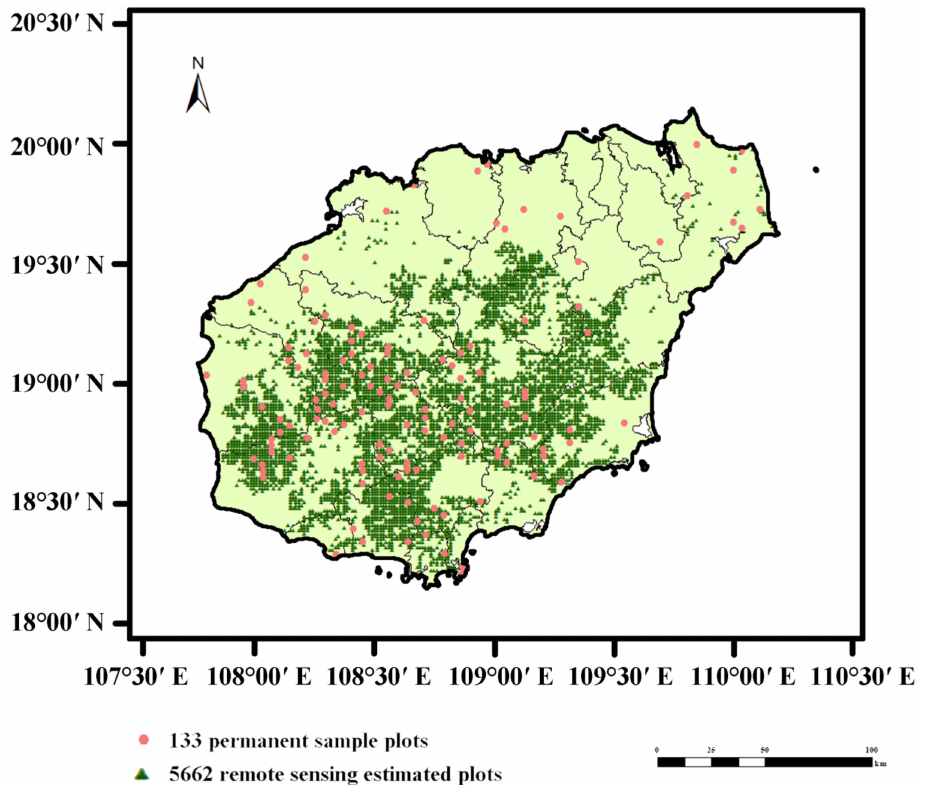
Figure 3. Permanent sample plots and distribution of sample points estimated by remote sensing in Hainan